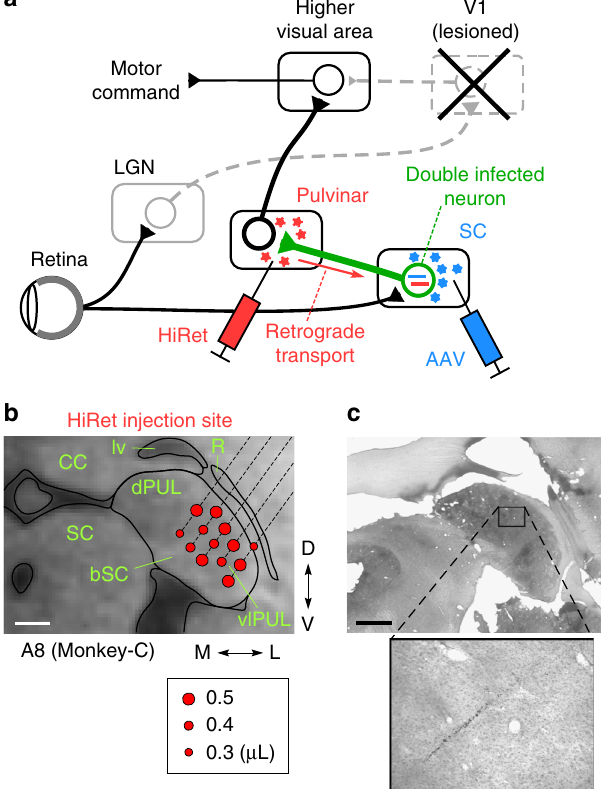
Fig. 5 Selective blockade of the SC – vlPul pathway by using two viral vectors. a The retrograde gene transfer viral vector (HiRet-TRE-eGFP. eTeNT) was injected into the vlPul and the anterograde viral vector (AAV1- CMV-rtTAV16) was injected into the SC. Then double infection occurs only on the neurons whose cell bodies were in the SC and whose axons projected to the vlPul. The synaptic transmission from SC neuron to vlPul is selectively blocked under the administration of Dox. See Supplementary Figure 5 and Methods for detail. b Representative locations of the HiRet injections. Red dot indicates the injection site and volume (inset). See Supplementary Figure 6 for all the injections. c Above: Nissl-stained histological section corresponding to b . Below: magni fi ed area showing the most dorsal injection track. Black rectangle indicates the magni fi ed area.